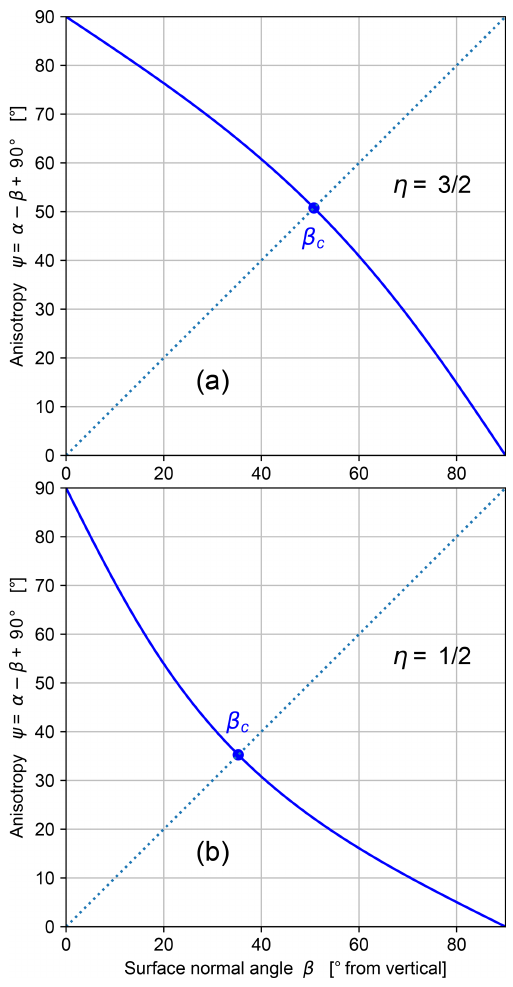
Figure 8. Erosional anisotropy measured using ray vs. normal an- gular disparity ψ = α − β + 90 ◦ : variation with surface tilt β shown for (a) η = 3 and (b) η = 1 and with µ/η = 1 2 2 2